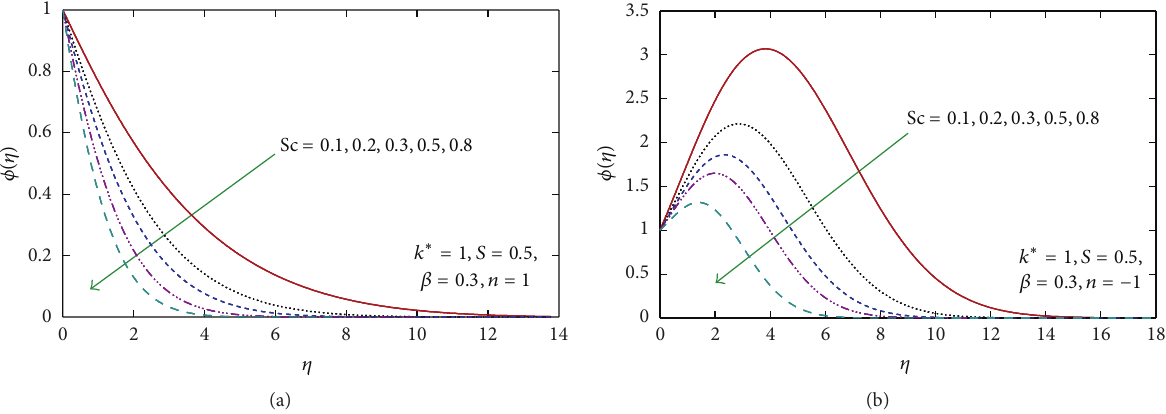
Figure 6: (a) Concentration profiles 𝜙(𝜂) for different values of Sc with 𝑛 > 0 . (b) Concentration profiles 𝜙(𝜂) for different values of Sc with 𝑛 < 0